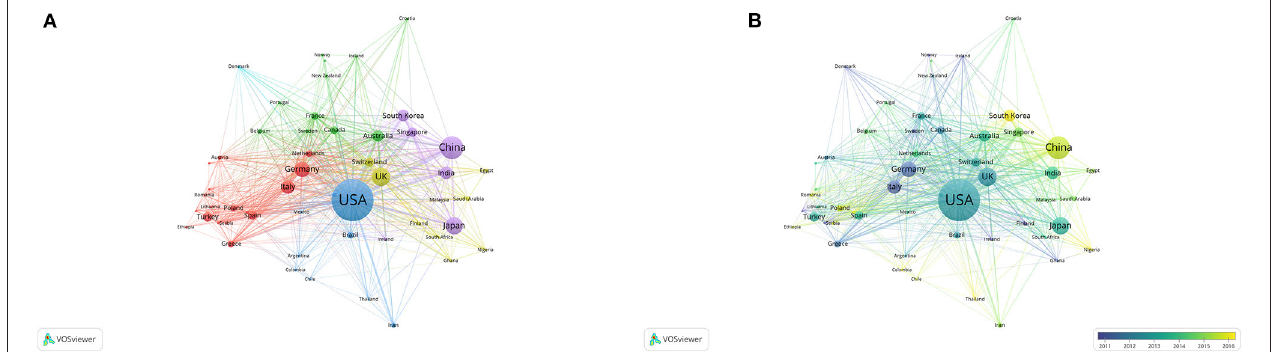
FIGURE 2 | Cooperation map of countries in the studies of POAG. (A) Mapping of the co-authorship analysis amongst 69 identified countries. Each node represents an individual country, and the node size is proportional to the number of publications. Line thickness between nodes indicates link strength of a collaboration relationship (weighted by a quantitative evaluation indicator of TLS). (B) Country overlay. The color of each node represents the average year of POAG publications in a country. Blue represents the earlier published countries, while yellow represents the recently published countries.